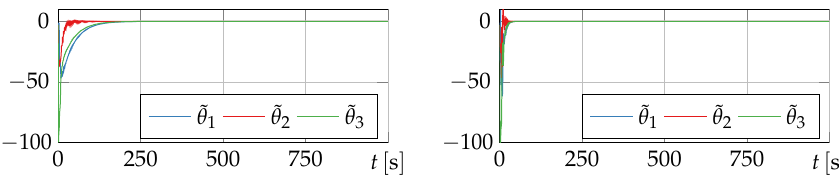
Figure 8. Results of the simulation with regressor depending on the state and different adaptation gains. ( Left ): Γ = 0.5 I , ( Right ): Γ = 5 I